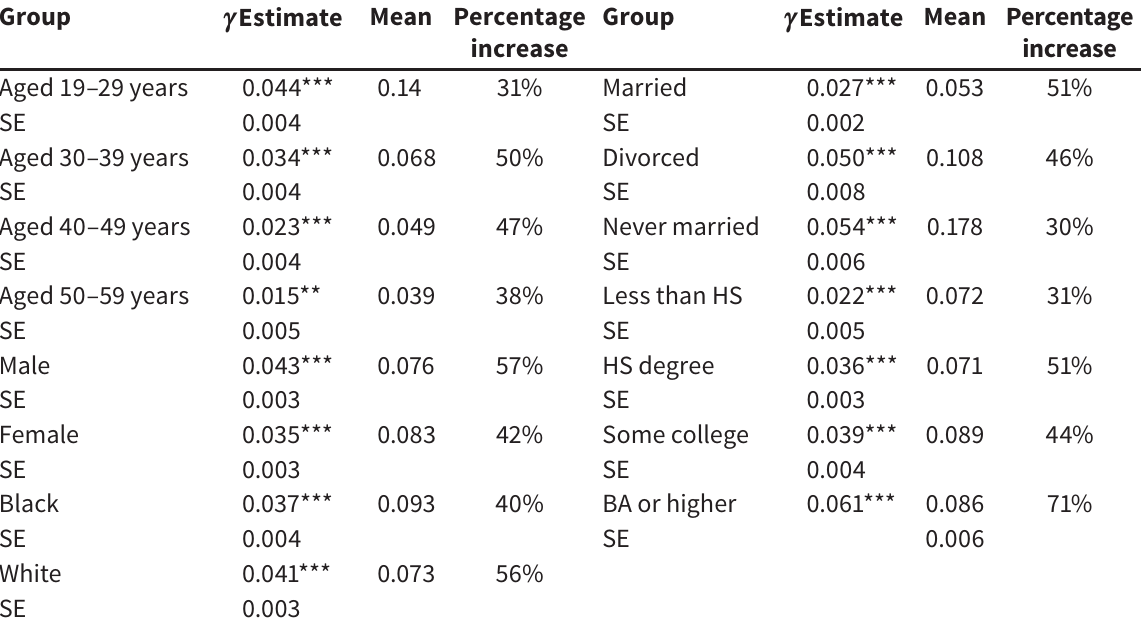
Coefficient estimate of regression of family transfer receipt on unemployment, by demographic subgroup, heads of household and spouses aged 19–59 years, 1976–2013